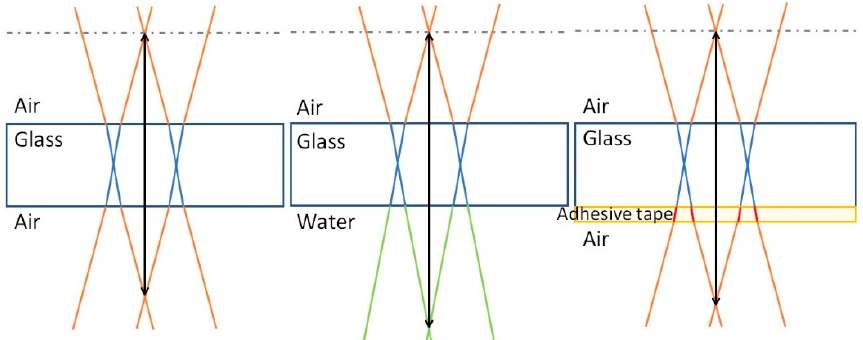
Figure 6. Schematic representation of the evolution of the Bessel beam geometry in different media. The intensity increase of the BB (core intensity) when propagating through the bottom surface is greater for the glass/air interface case (left) than for the glass/water interface case (center). On the other hand, the intensity of the BB decreases at the interface glass/adhesive tape.